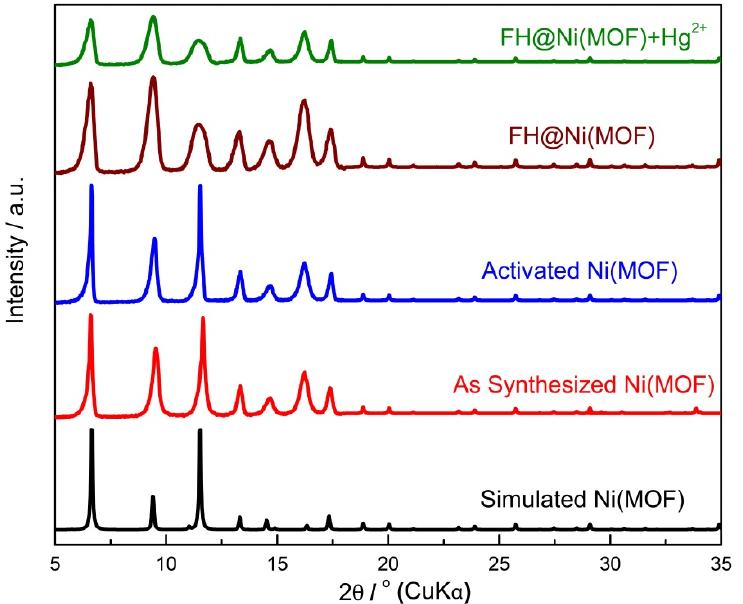
Figure 1. Powder X-ray diffraction (PXRD) analysis of FH@Ni(MOF). The simulated pattern (black) of Ni(MOF) matches well with the as-synthesized sample of Ni(MOF) (red), activated Ni(MOF) (blue), FH-appended sample FH@Ni(MOF) (brown), and FH@Ni(MOF) after the addition of Hg 2+ (green).